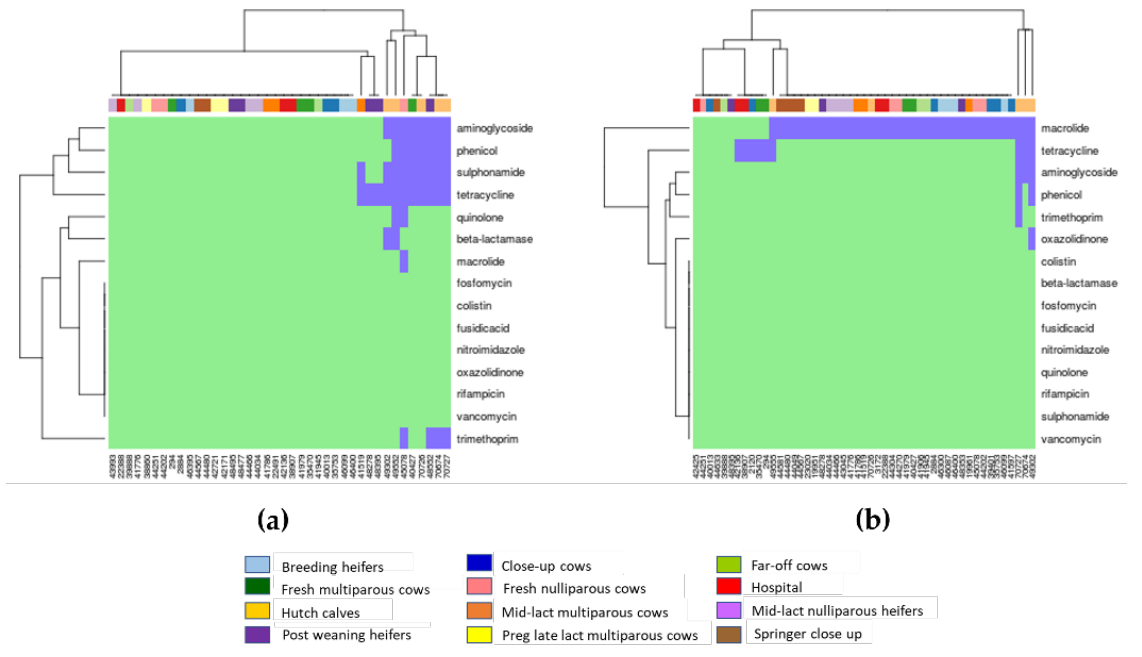
Figure 1. Heat map of resistance genes in E. coli and Enterococcus from dairy cattle at different production stages based on the